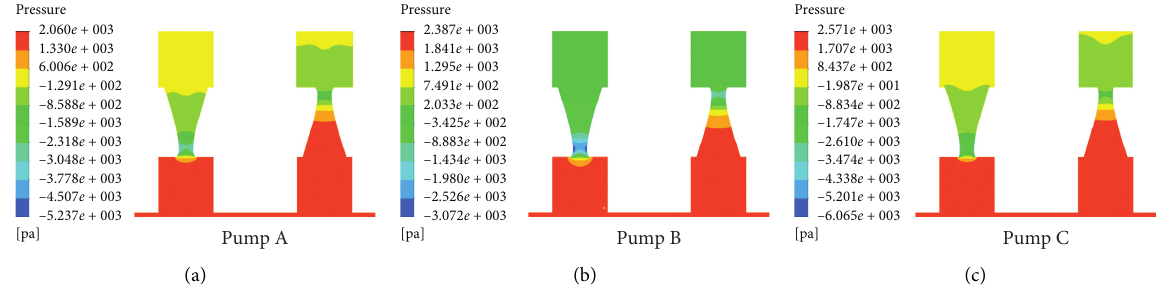
Figure 2: The pressure diagrams of the pumps in the schedule stage.